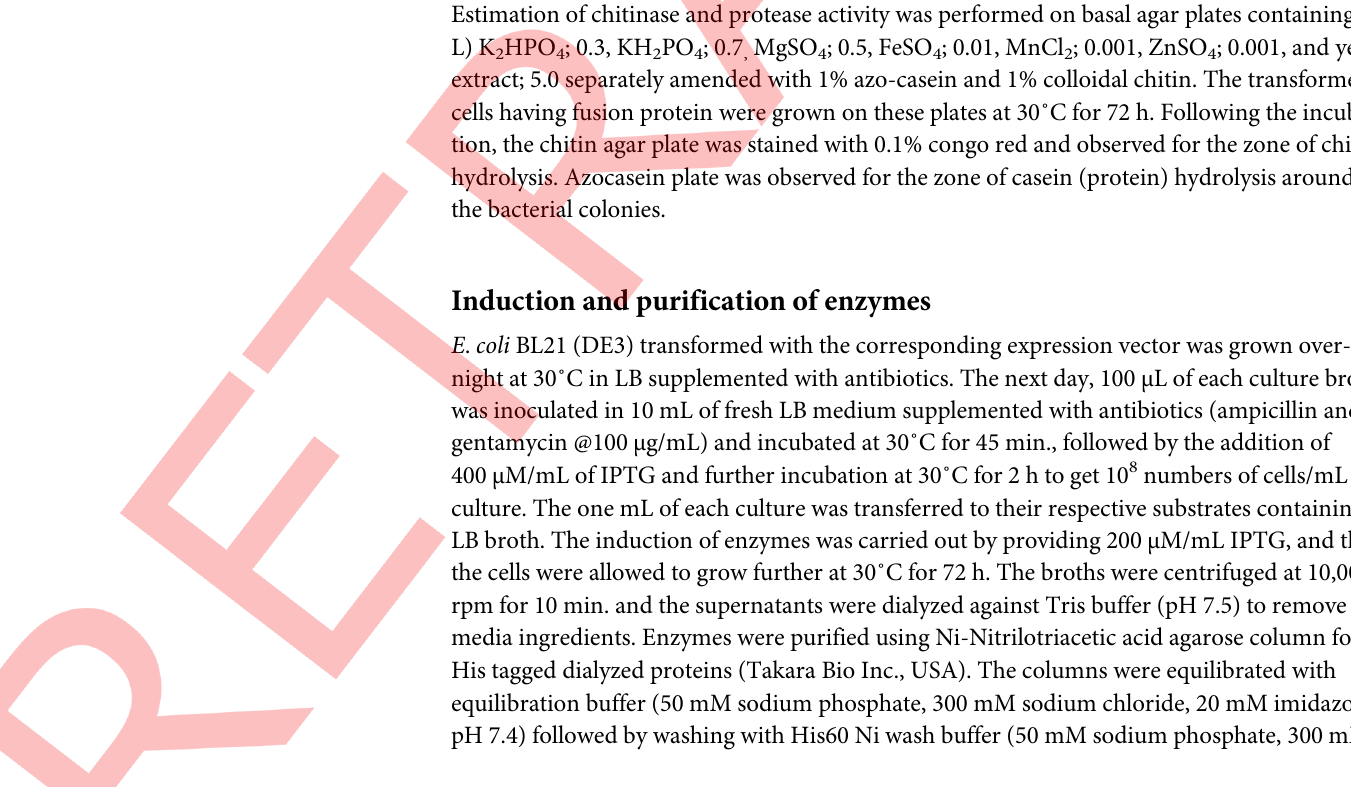
Estimation of enzyme activities of the different constructs